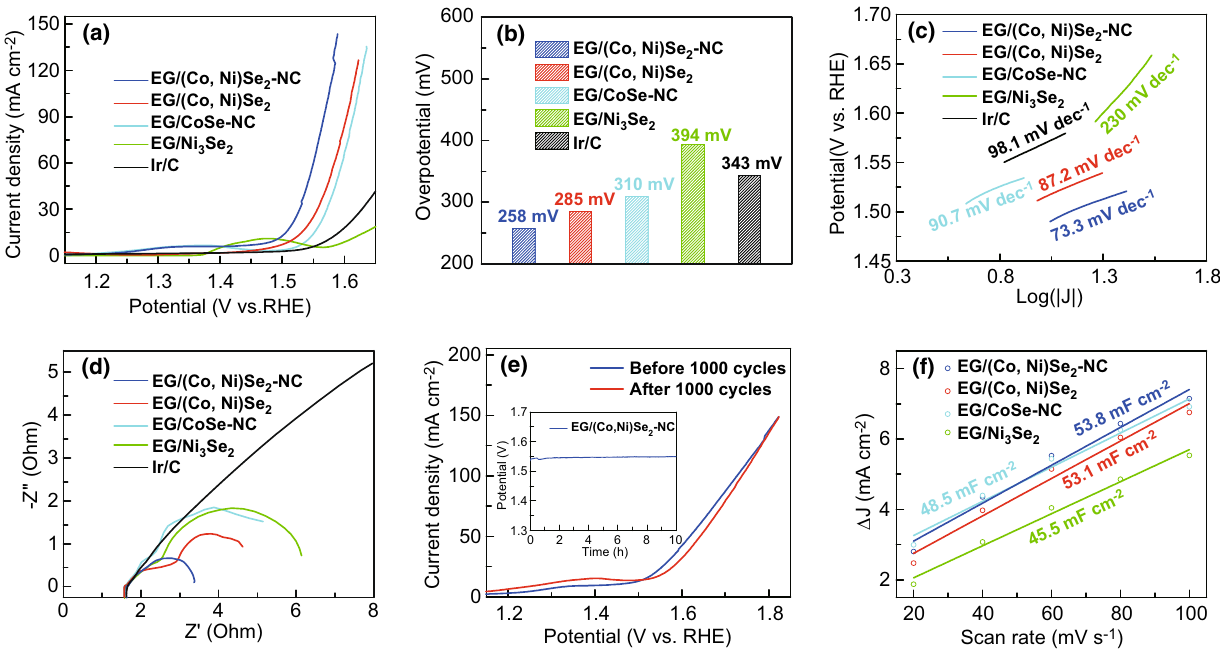
Fig. 4 a Polarization curves, b overpotential plots at 10 mA cm −2 , c Tafel slopes, d EIS spectra of EG/(Co, Ni)Se 2 –NC, EG/(Co, Ni)Se 2 , EG/ CoSe-NC, EG/Ni 3 Se 2 , and Ir/C. e Polarization curves of EG/(Co, Ni)Se 2 –NC before and after CV cycles scanning. inset: chronoamperometric E - t plot at 20 mA cm −2 . f C dl plots of EG/(Co, Ni)Se 2 –NC, EG/(Co, Ni)Se 2 , EG/CoSe-NC, and EG/Ni 3 Se